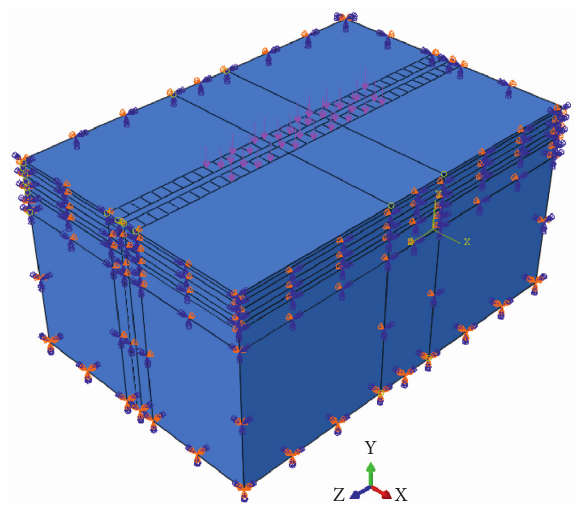
Figure 3: 3D model and boundary conditions.